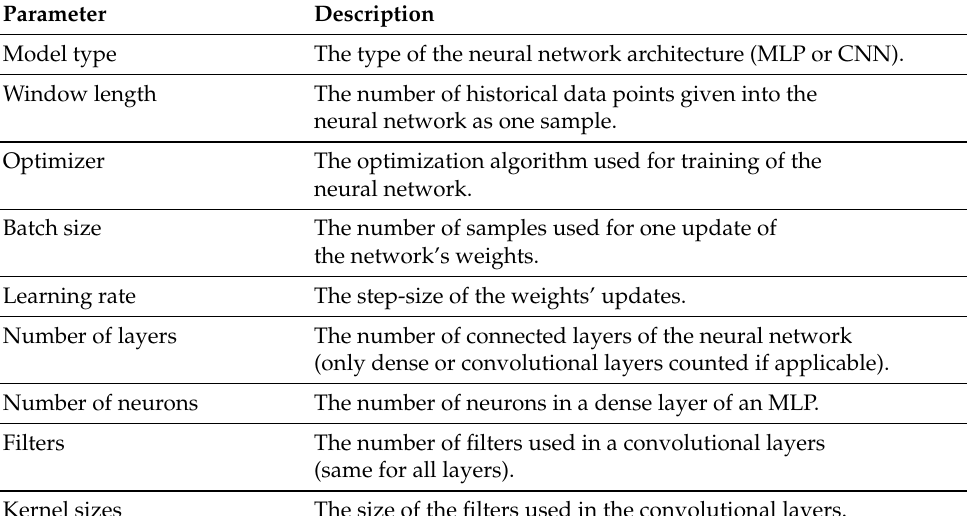
Table 2. Considered hyper-parameters in this